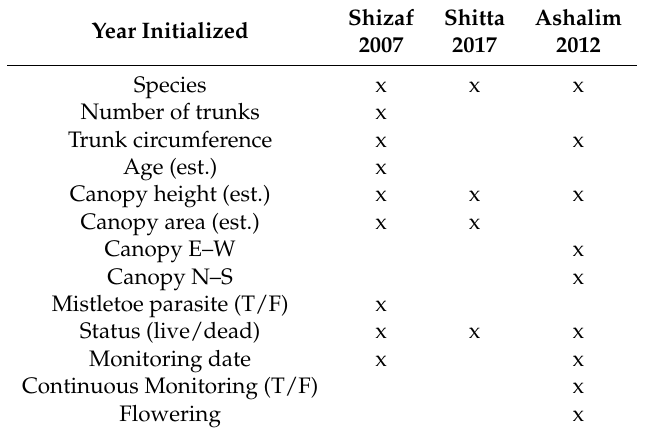
Table 1. Auxiliary data collected at each study area during monitoring